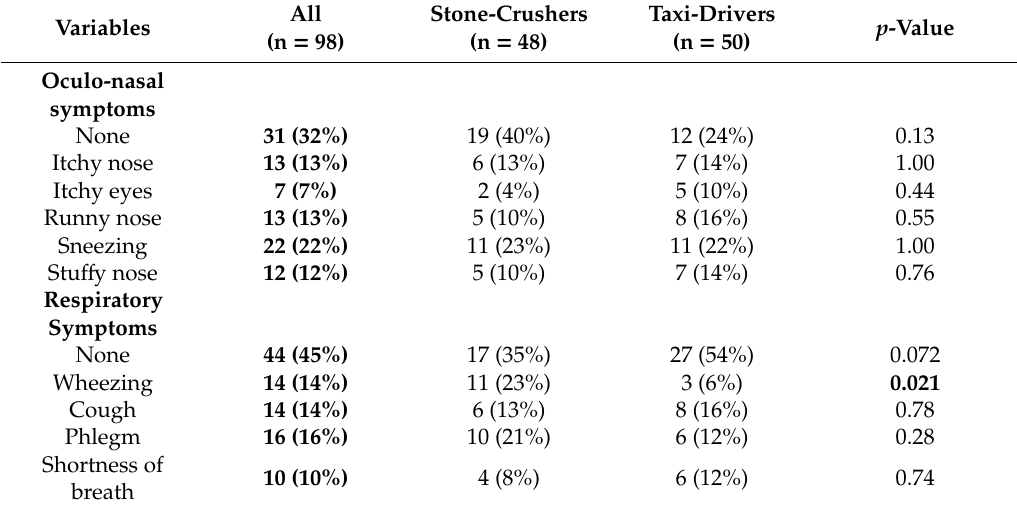
Table 3. Prevalence of reported symptoms (within the past 12 months) among stone-crushers and taxi-drivers.